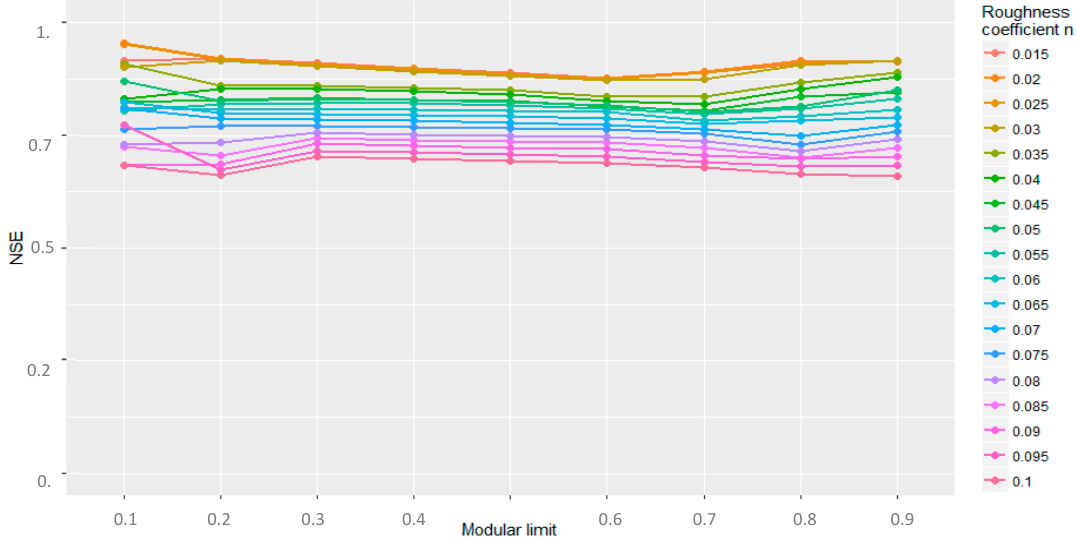
Figure 7. NSE values for each configuration of modular limit and roughness coefficient n .